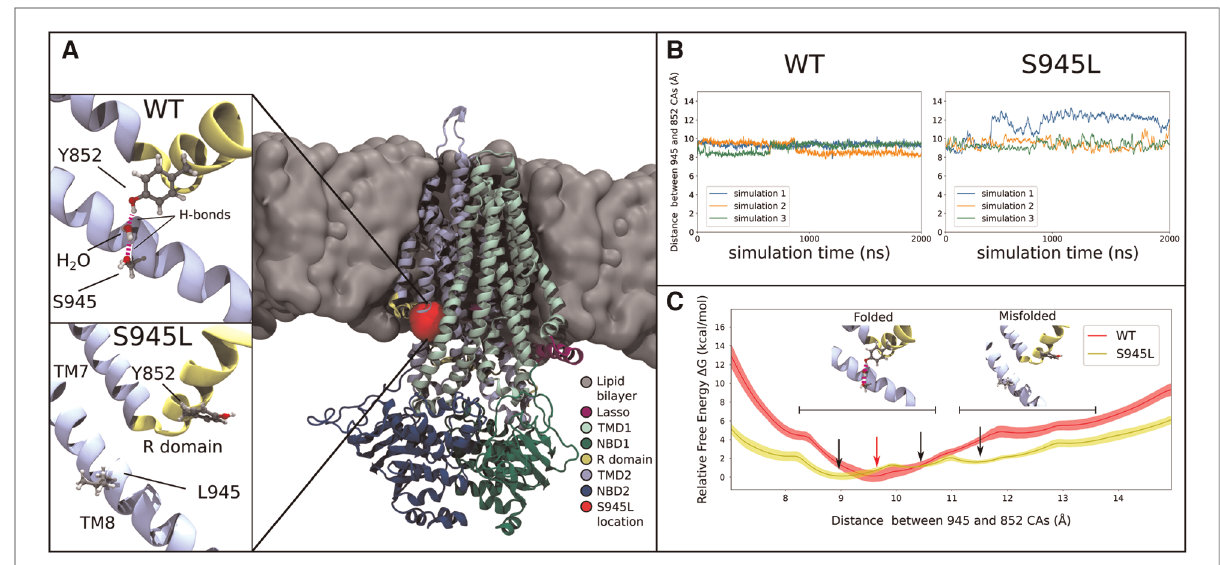
FIGURE 3 Molecular dynamics and free energy calculations to characterise the S945L mutation. ( A ) The open structure of the CFTR protein is used in all computational work (PDB ID: 6MSM), which is depicted here as coloured ribbons embedded within a grey lipid bilayer. A red blob shows the location of the S945 amino acid between TM8 and the R domain; this region is critical for channel gating functions. In simulations 1, 2 and 3 of WT-CFTR, a network of hydrogen bonds is found that connects Y852 to S945. This network is absent in simulations of S945L-CFTR, as the mutation replaces the polar serine side chain with a hydrophobic leucine side chain that is incapable forming hydrogen bonds. ( B ) The distance between S/L945 and Y852 alpha carbon atoms measured in three unbiased simulations of WT- and S945L-CFTR at 77°C (350 K). The distance trace is stable in WT-CFTR due to the formation of hydrogen bonds between Y852 and S945, where the alpha carbons of these amino acids remain at a distance of 9.1±0.3 Å. Distances are denoted here by Mean±SD. Some destabilisation is seen in S945L-CFTR with unbiased MD: in simulations 2 (orange) and 3 (green) the average distance is 9.4±0.5 Å, while in simulation 1 (blue line), a conformational transition occurs after approximately 400 ns, that increases the average distance to 12.0±0.6 Å. ( C ) Relative free energy as the distance between S/L945 and Y852 is varied in umbrella sampling calculations. In WT-CFTR there exists one deep free energy minimum at 9.5 Å (red arrow). In S945L-CFTR there are instead three shallow free energy minima between 9.0 Å and 13.0 Å (black arrows), separated by small barriers with heights of 2.0 kcal/mol or less. Black horizontal bars indicate regions of two distinct local conformations: one at distances below 10.8 Å, where the R domain and TM8 are properly folded and a Y852-S945 hydrogen bond network exists; the other at distances above 11.2 Å, where the R domain and TM8 separate into a misfolded conformation. The relative free energies obtained through umbrella sampling suggest that such misfolding is more likely to occur in